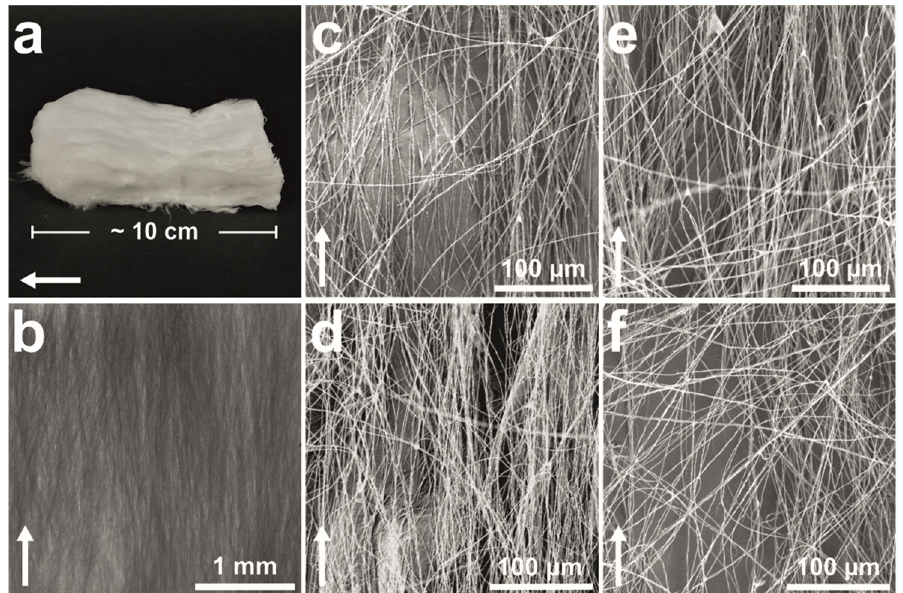
Figure 3. CNF filaments. ( a ) A photograph and ( b ) an optical microscope image of a CNF filament network. FESEM images of non-silylated ( c ) 1.1 and ( d ) 0.56 µm and silylated ( e ) 1.1 and ( f ) 0.56 µm filaments. The white arrow indicates the freezing direction.